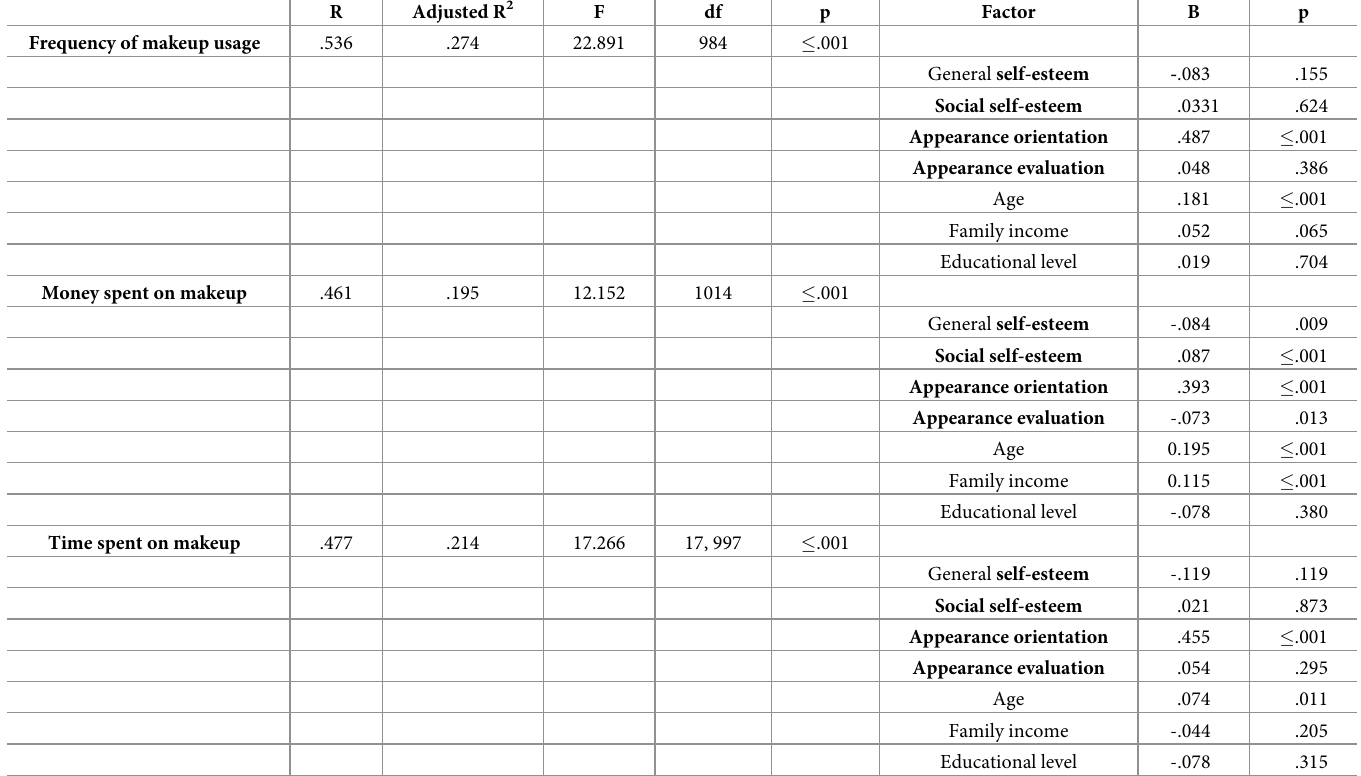
Table 2. Categorical